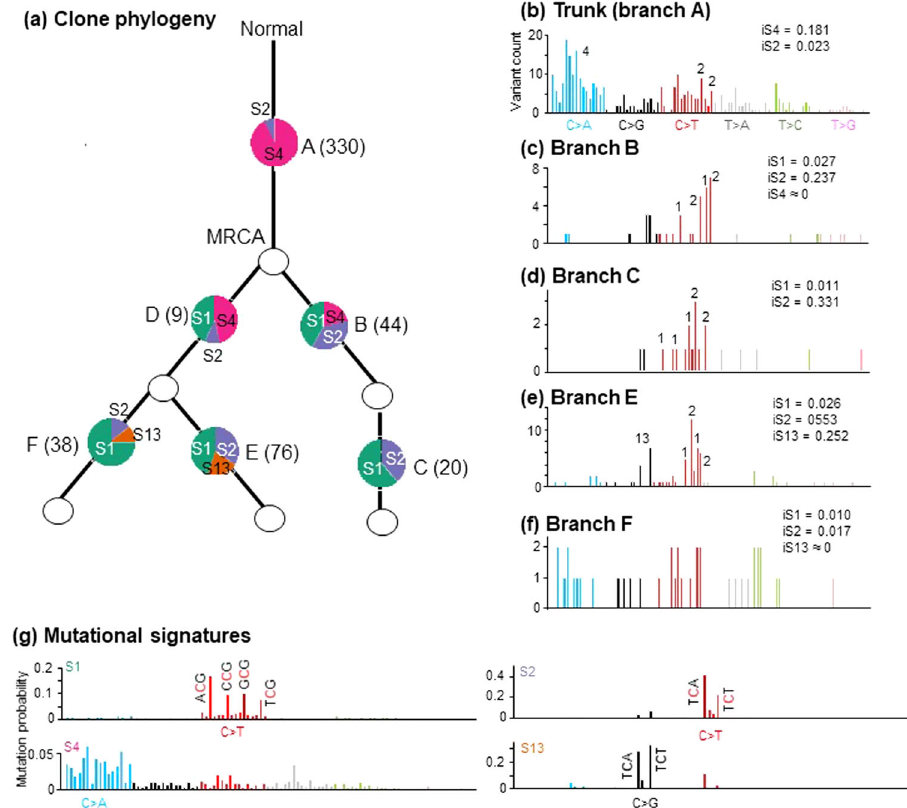
Fig. 6 PhyloSignare (PSQP) inferences on CRUK0025 patient data. a Clone phylogeny and the mutational signatures identi fi ed for different branches (A − F). The number in the parentheses is the variant count for each branch, and a pie chart shows the relative activities of mutational signatures. The most recent common ancestor (MRCA) of all observed clones is marked. b – f Distribution of variants observed at each branch. The numbers on top of the vertical bars correspond to variant types that were important for COSMIC signatures detected. g Distribution of variants for four COSMIC signatures detected for this phylogeny (S1, S2, S4, and